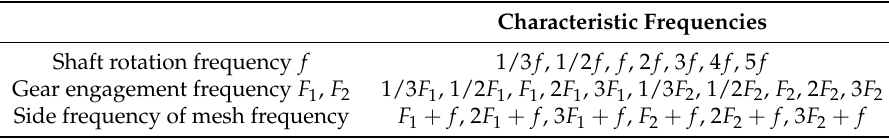
Figure 9. Data processing results on shaft II. ( a ) Spectral analysis after node reconstruction [5 2]. ( b ) Spectral analysis after node reconstruction [5 3]. ( c ) Spectral analysis after node reconstruction [5 4]. ( d ) Spectral analysis after node reconstruction [5 7]. ( e ) Spectral analysis after node reconstruction [5 6]. ( f ) Spectral analysis after node reconstruction [5 9]. Table 3. Summary of characteristic